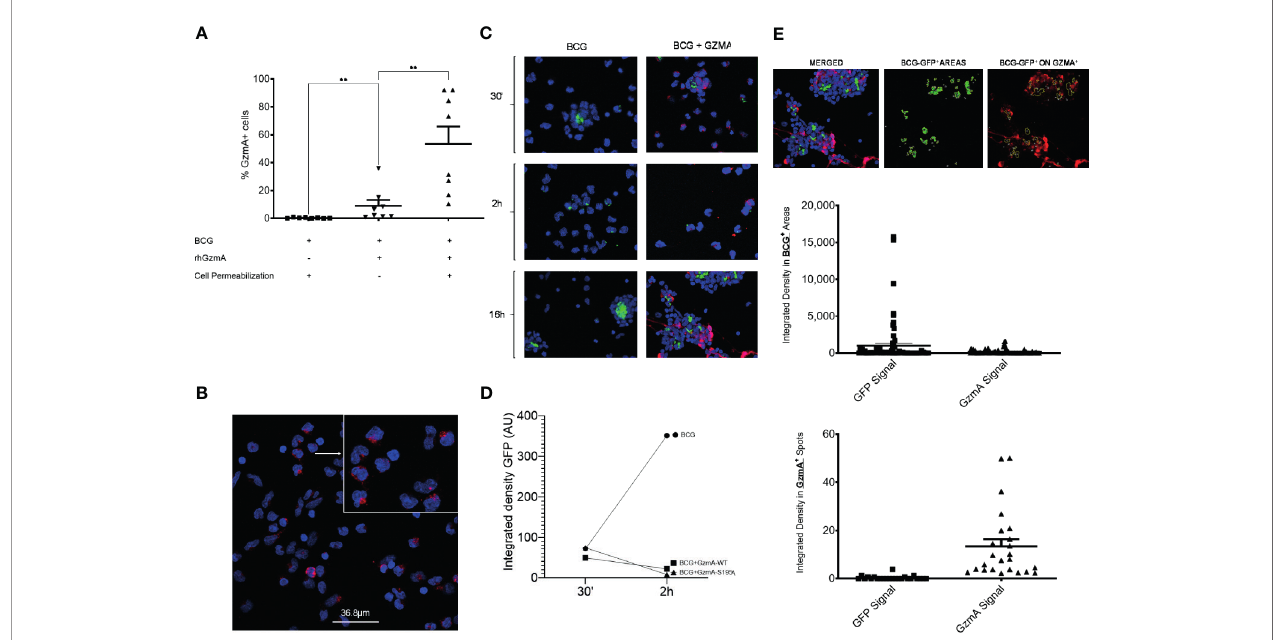
FIGURE 3 | GzmA is internalized in infected monocytes. (A) In fl ow cytometry studies comparing surface vs. intracellular staining, the majority of GzmA is inside the monocytes after treatment (n=8 in at least two independent experiments; means and SEM; Wilcoxon matched-pairs signed rank test). Similarly, GzmA is shown to be adjacent to the nucleus of treated monocytes as seen by confocal microscopy. (B) Representative confocal microscopy image showing GzmA in red and DAPI (nuclear stain) in blue. (C) Representative confocal microscopy images from three separate experiments showing GzmA in red, DAPI (nuclear stain) in blue, and BCG-GFP in green. Comparing 30 min and 2 h post-infection, GzmA-treated cells show lower bacterial burden. (D, E) Image analysis isolating BCG-GFP+ areas at 16 h post-infection: superimposition of areas where BCG is present and GzmA. GzmA and BCG are not found in the same cells as visually represented in images and measured in graphs by looking at integrated density signal of BCG and its overlap with GzmA (E) (mean, at least three independent experiments) (*p < 0.05, **p < 0.01, ***p < 0.001; ns, not signi fi cant). been implicated in mycobacterial control, consistent with TABLE 1 | Groups for proteomic analysis. our fi ndings. Differentially Abundant Proteins Discovered With 2D-DIGE Are Also Differentially Abundant as Measured With Quantitative Western Blot Analysis To validate our global proteomic data, we quanti fi ed the levels of three ER stress response proteins BiP, PDIA1, and Endoplasmin